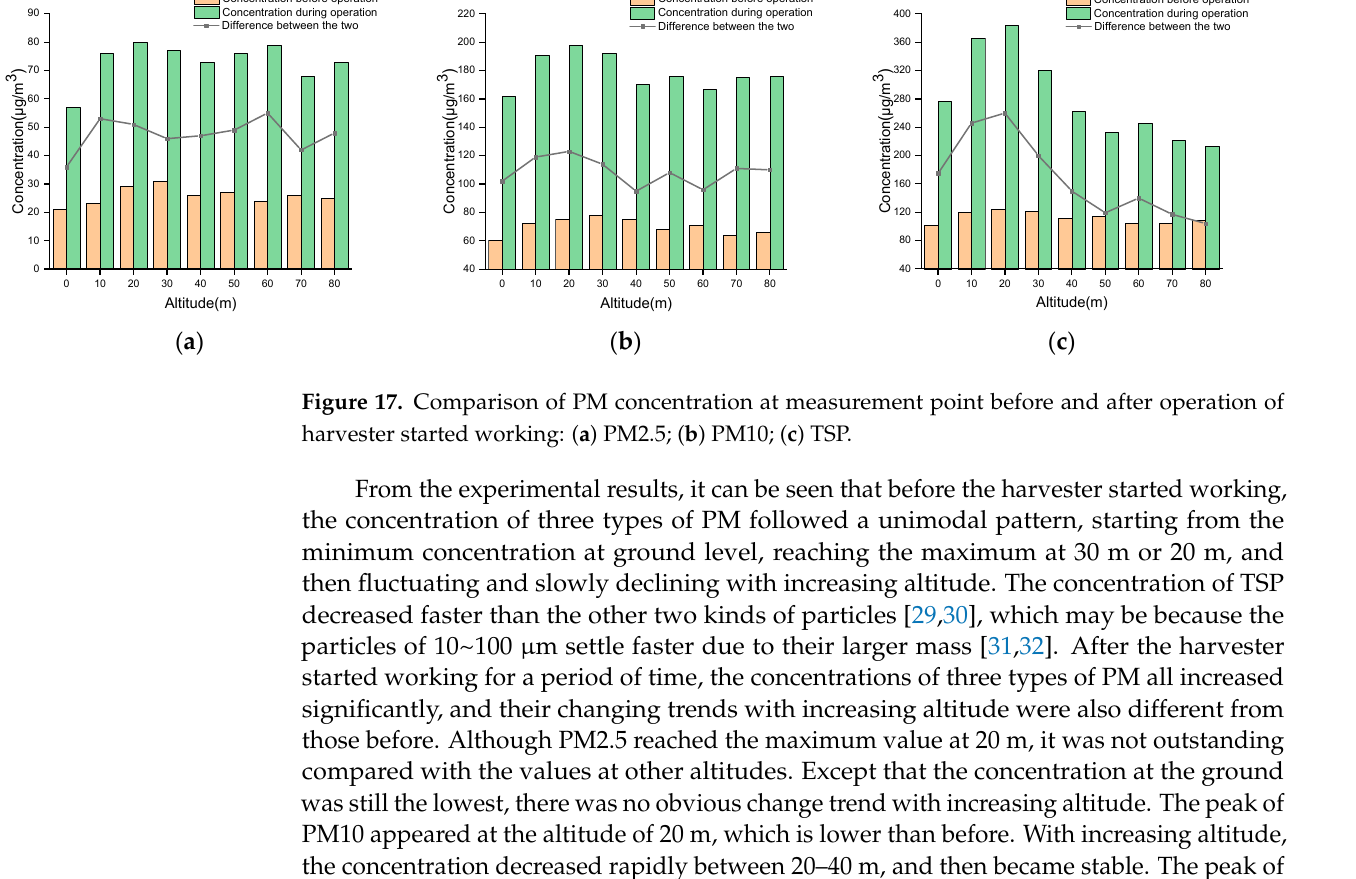
( b ) Figure 16. Comparison of spatial interpolation of PM concentration with flight measurement: ( a ) PM2.5; ( b ) PM10. From the experimental results, it can be seen that the flight measurements of PM2.5 and PM10 are very close to the calculated spatial interpolation, and the errors are only 5.87% and 2.91%, respectively. In the three monitoring stations, although station C is the farthest from the experimental site, the PM concentration is the closest to the flight meas- urement value, presumably because station C is in the upwind direction of the experi- mental site, and the correlation between them is greater. The experimental results shows that our environmental monitoring system has high application value. 4.4. Agri-Environment Measurement Experiment Results